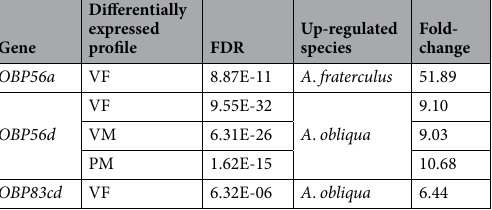
Table 1. Significance and fold-change values of the RNA-seq differential expression analyses between A . fraterculus and A . obliqua OBP genes. VF = virgin female; VM = virgin male; PM = post-mating male. FDR = false discovery